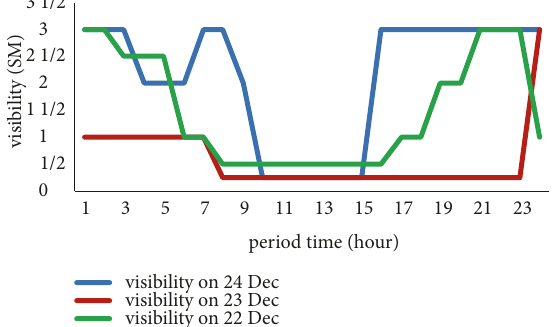
Figure 9: Comparison between the visibilities on typical congestion days.